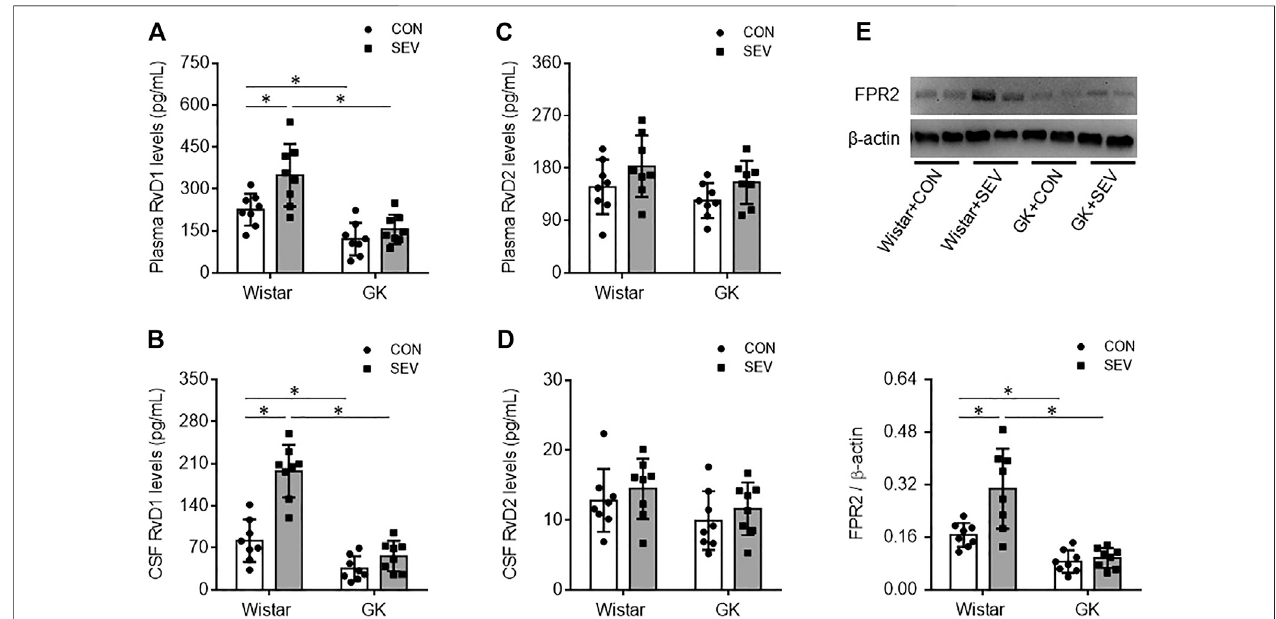
FIGURE 1 | Levels of resolvin D1 (RvD1) and resolvin D2 (RvD2) in plasma (A and C) and cerebrospinal fl uid (CSF) (B and D) and protein expression of their receptor FPR2 in the hippocampus (E) in non-diabetic Wistar rats and type 2 diabetic Goto – Kakizaki (GK) rats after control (CON) or sevo fl urane (SEV) exposure. Data are presented as mean ± SE (n (cid:1) 8 for each group). * p <